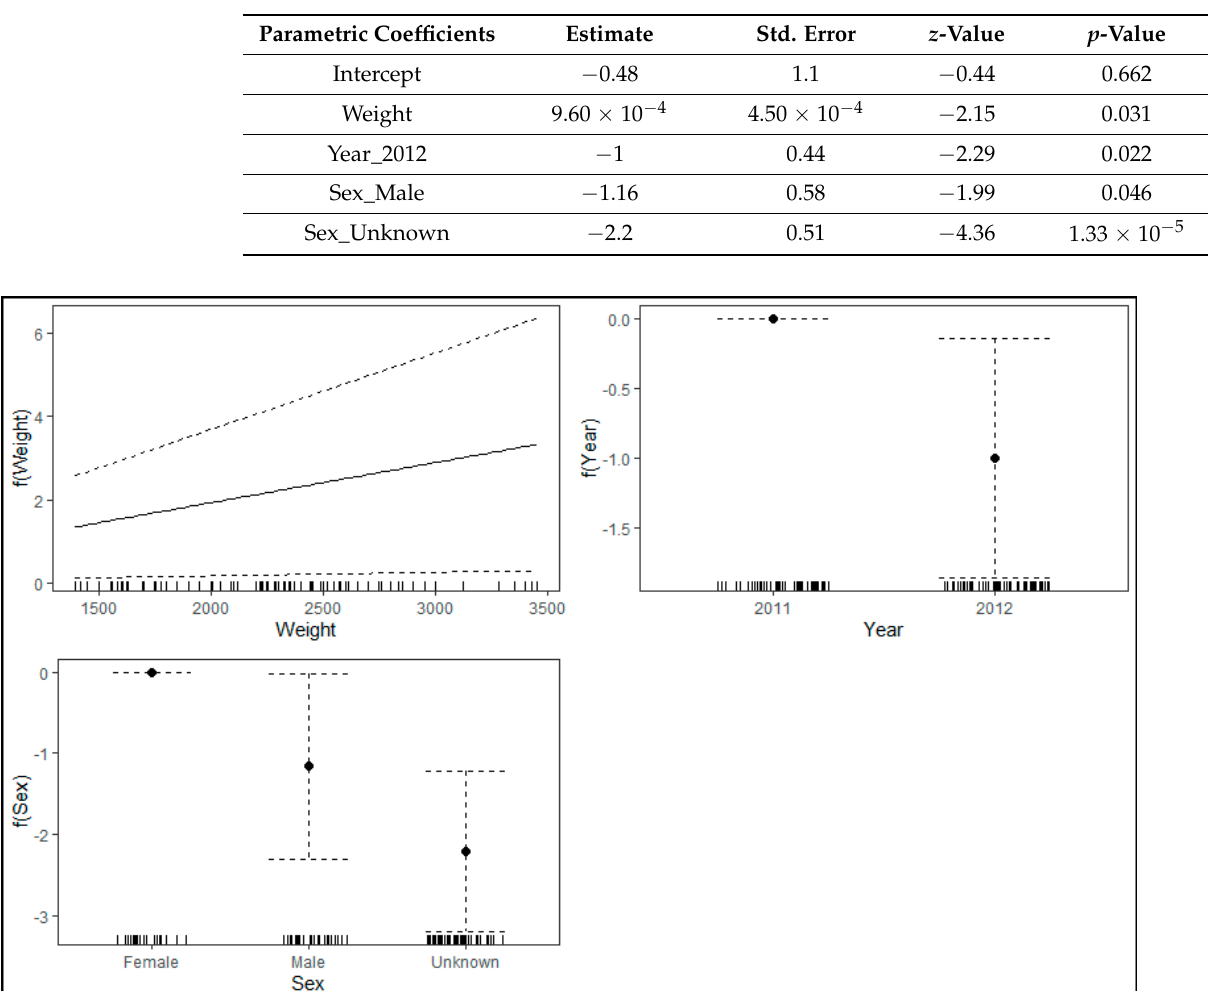
Table 3. Estimated regression parameters, standard errors, z -values, and p -values for the GAM. Parametric Coefficients